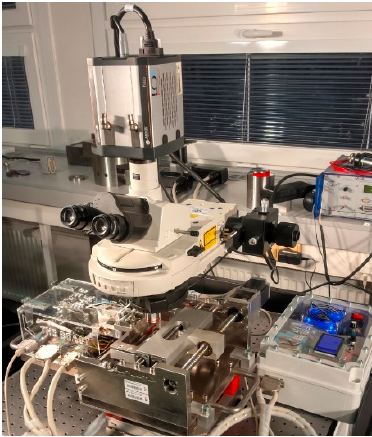
Figure 3 . Experimental apparatus. Figure 3. Experimental